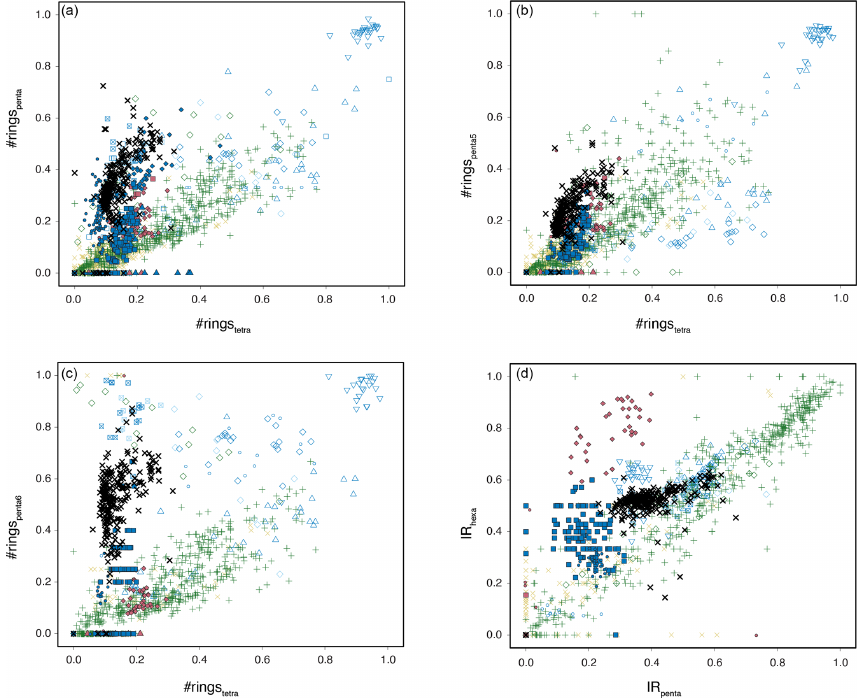
Figure 8. Cross plots of various brGDGT indices. (a) #rings tetra vs. #rings penta , #rings tetra vs. #rings penta5 , #rings tetra vs. #rings penta6 , IR penta vs. IR hexa . For the color and symbol legend, see Fig.